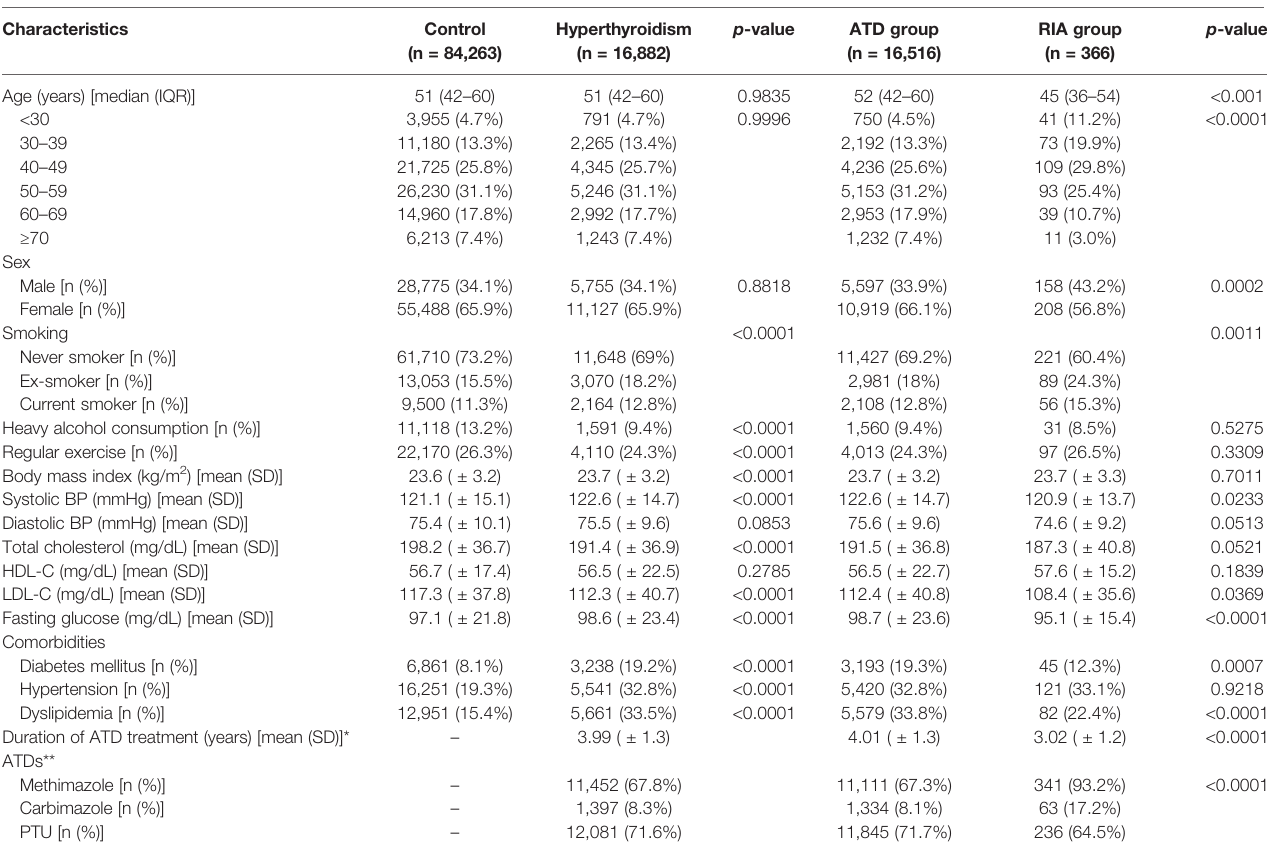
TABLE 1 | Baseline